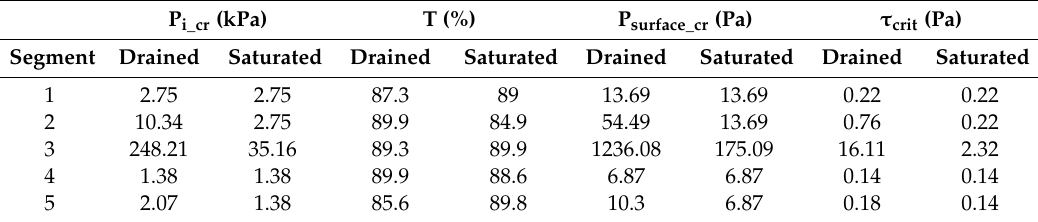
Table 3. Average ( n = 3) cohesive strength meter (CSM) pressures for initiation of scour (P i_cr ), average ( n = 3) transmission values (T), equivalent pressure at the surface (P surface_cr ), and estimated critical shear stress for erosion ( τ crit ) obtained from Equation (2) for ditch segments 1–5. P i_cr (kPa) T (%) P surface_cr